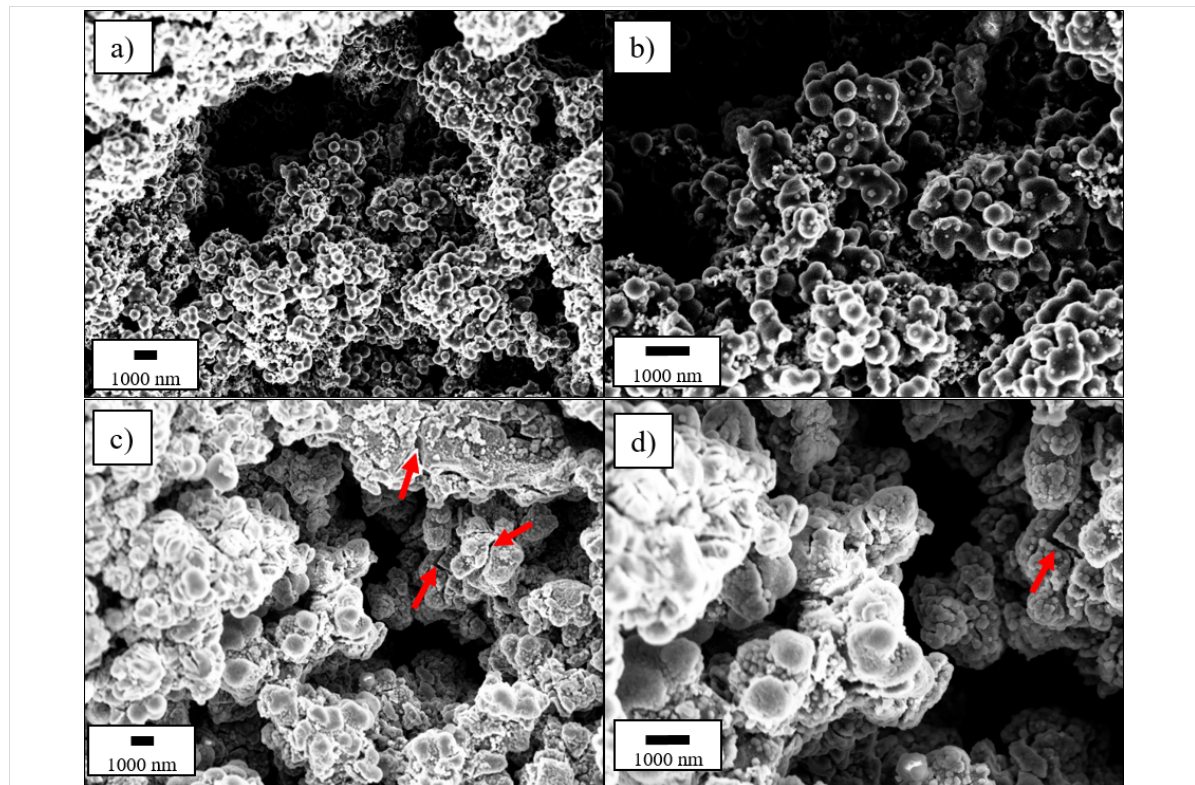
Figure 5: SEM micrographs of cycled electrodes after 13 cycles (including 3 formation cycles) of the C:Si 90:10 (a, b) and C:Si 80:20 composite (c,d).